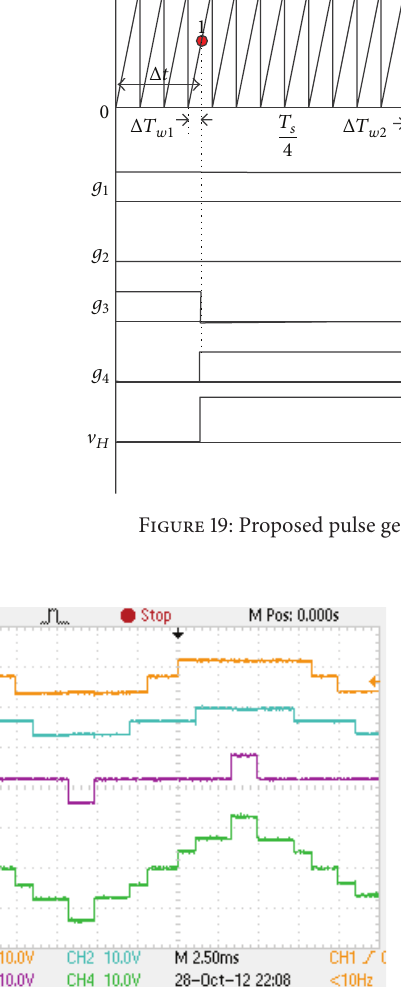
Figure 21: Five-stage 11-level staircase